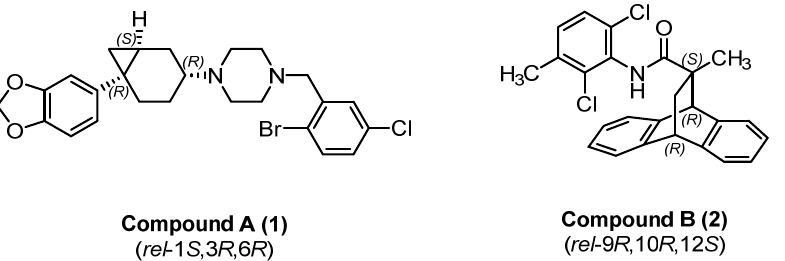
Figure 1. High-throughput screening hits racemic Compound A [1-(( rel -1 S ,3 R ,6 R )-6- (benzo[ d ][1,3]dioxol-5-yl)bicyclo [4.1.0]heptan-3-yl)-4-(2-bromo-5-chlorobenzyl)piperazine] (1) and racemic Compound B [ rel -(9 R ,10 R ,12 S )- N -(2,6-dichloro-3-methylphenyl)-12-methyl-9,10-dihydro- 9,10-ethanoanthracene-12-carboxamide] ( rac - 2 ) reported by Lewis et al. [36].